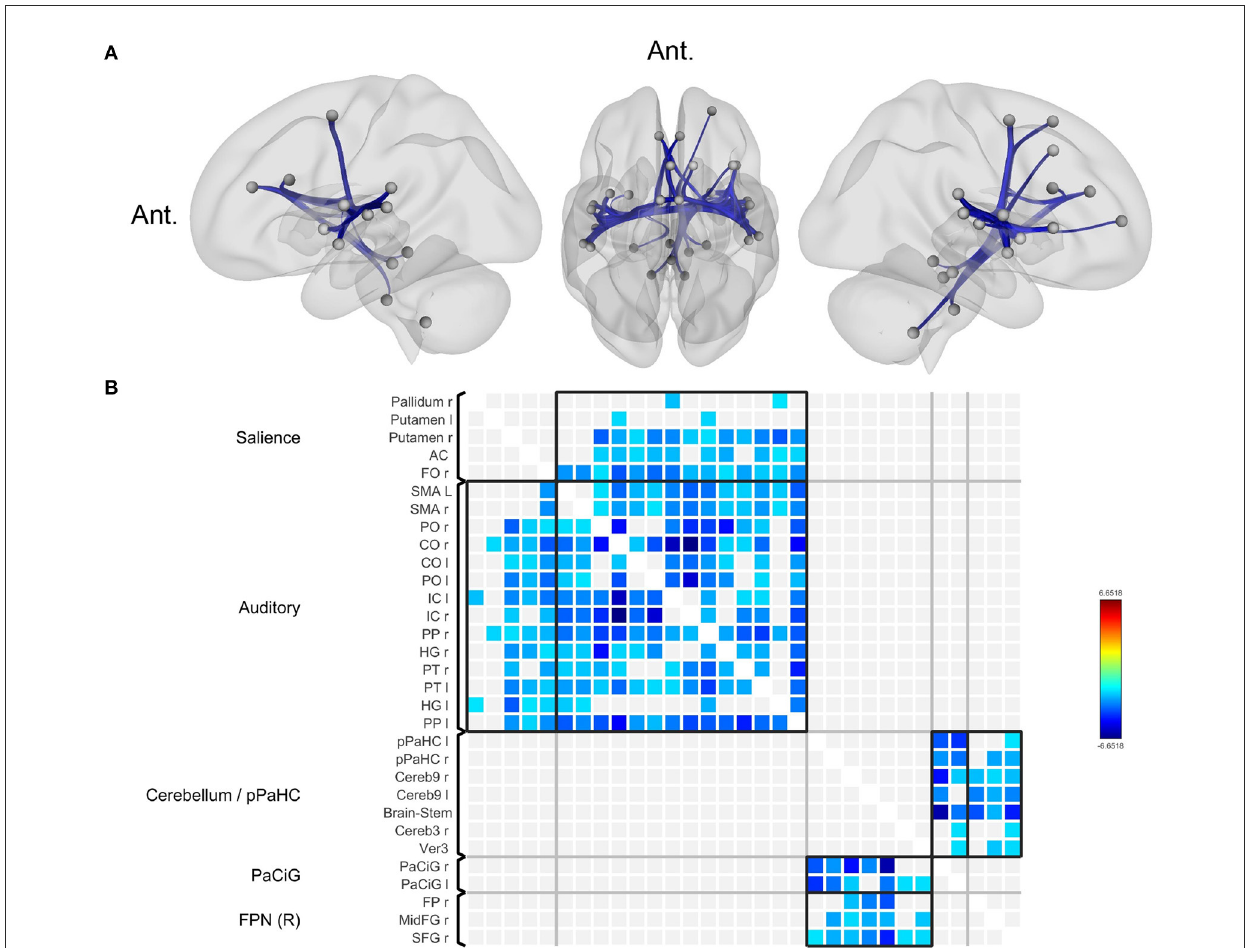
FIGURE1 Decreased functional connectivity in bilateral vestibulopathy. (A) Patient with bilateral vestibulopathy showed decreased functional connectivity in the bilateral insular, lateral occipital, fusiform, and anterior cingulate cortices. Seed-level two-sided false discovery rate (FDR) corrected p < 0.05. (B) The connectivity matrix showed brain regions with reduced functional connectivity correspond to salience and auditory